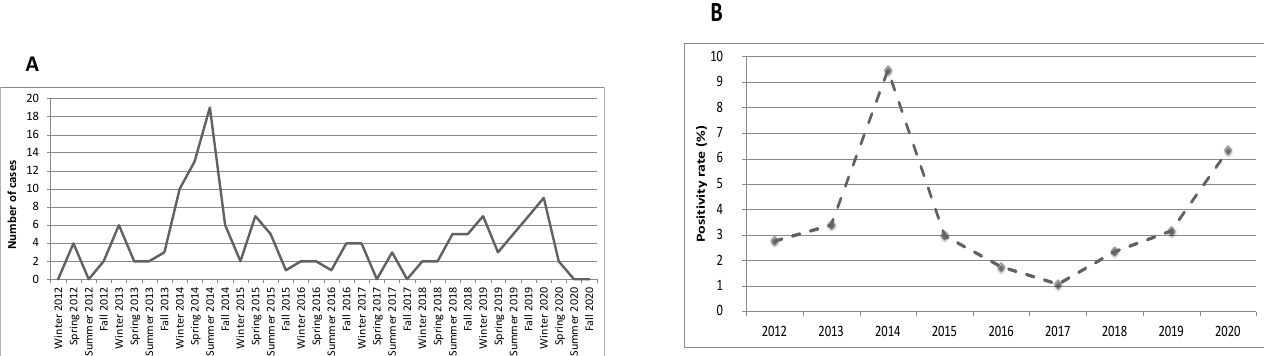
Figure 1. Age distribution of MP infection. The distribution of positive MP tests showed a peak during 2014, with 48 hospitalized patients (33.1% of the whole cohort) and a positivity rate of 9.5% (Figure 2).